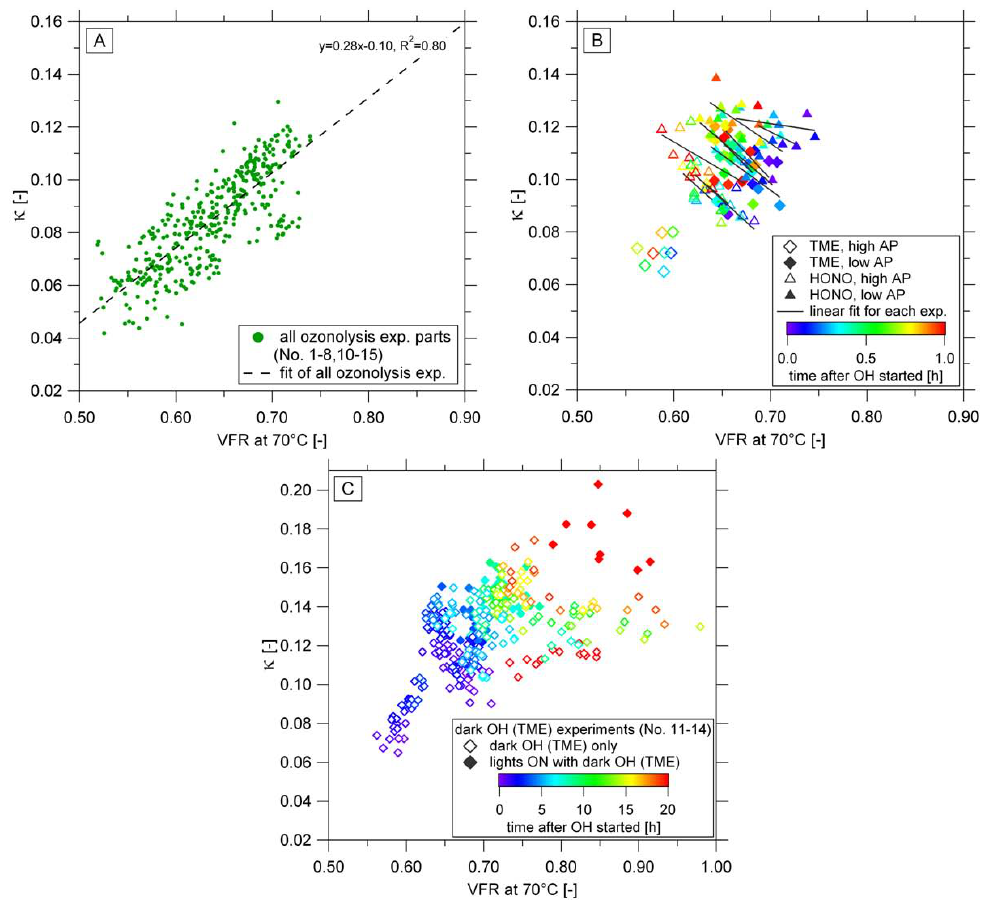
Fig. 8. Correlation of hygroscopicity parameter κ and VFR at 70 ◦ C of α -pinene SOA for several experiments and sections of experiments. Panel (a) shows the correlation for all available experiments during the ozonolysis part only. The positive correlation of κ and VFR can be presented by a linear fit. Panel (b) shows the anti-correlation of κ and VFR during the first hour after OH aging was started for dark OH (TME) experiments (diamonds) and HONO photolysis experiments (triangles). The same correlation is presented in panel (c) for experiments No. 11–14 during the reaction with OH from TME in absence of light (open symbols), sometimes with addition of lights (closed symbols). The data shown in panel (b) and (c) are color coded by time after OH